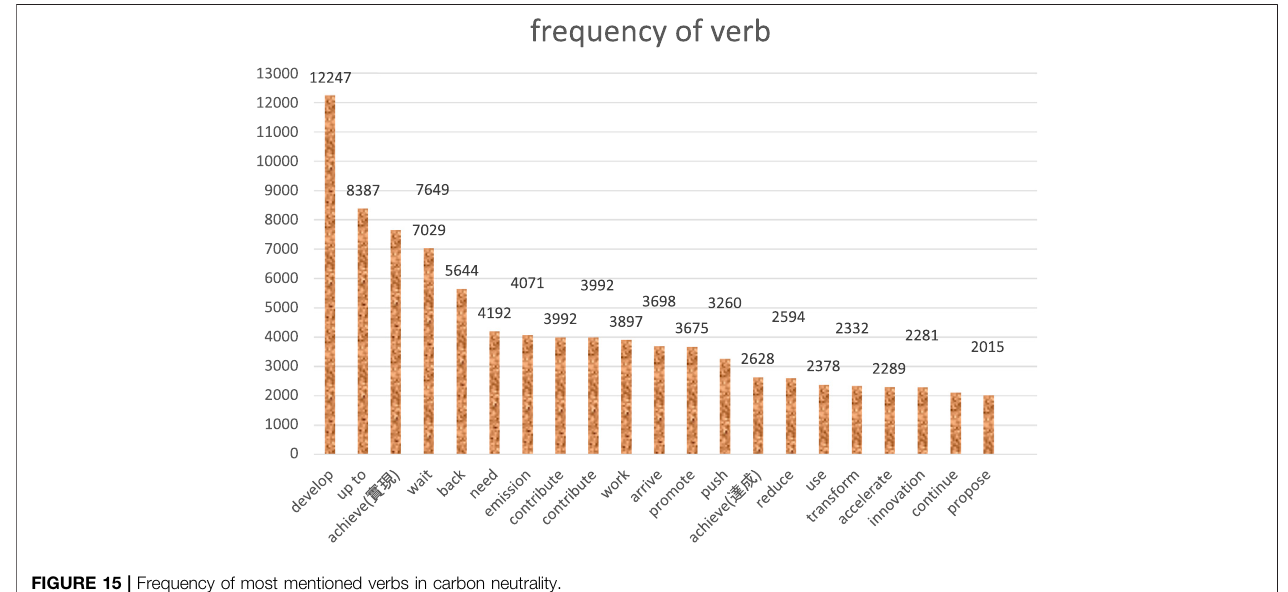
FIGURE 15 | Frequency of most mentioned verbs in carbon